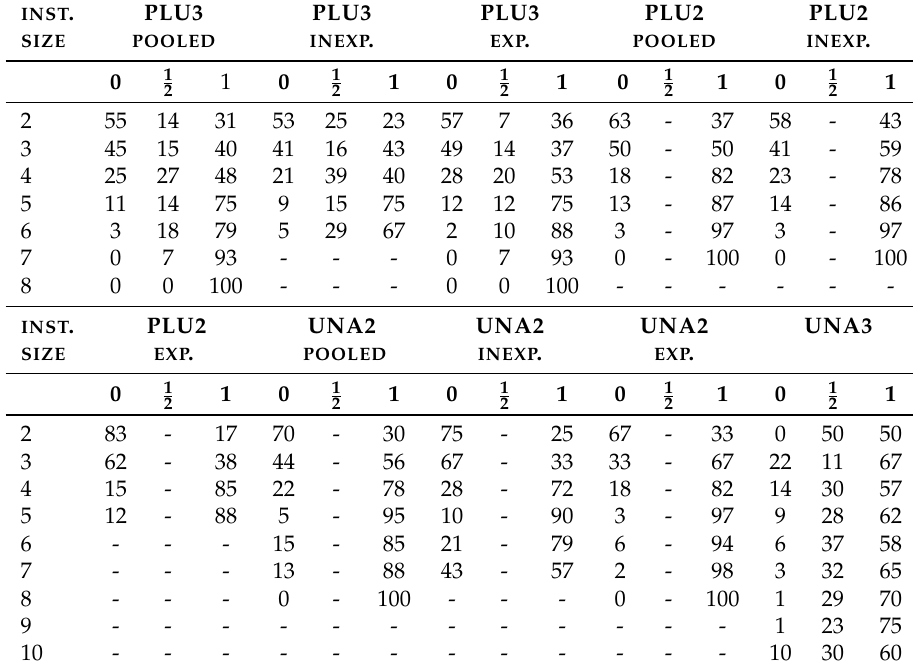
Table 7. Distribution of votes (%) among projects by institution